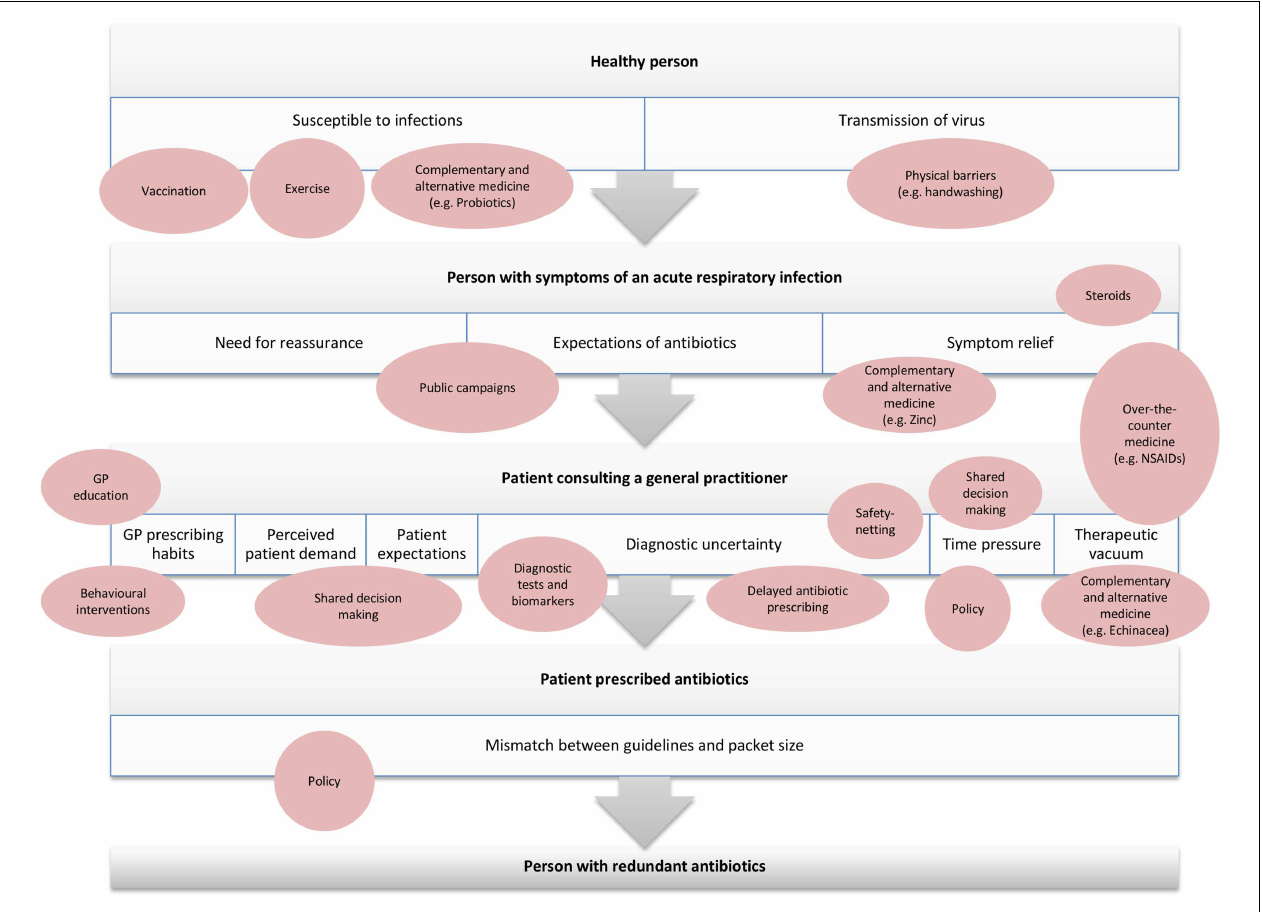
FIGURE 1 | Overview of strategies to minimize antibiotic use in primary care at each stage of the path from healthy person to antibiotic prescription for acute respiratory infection .